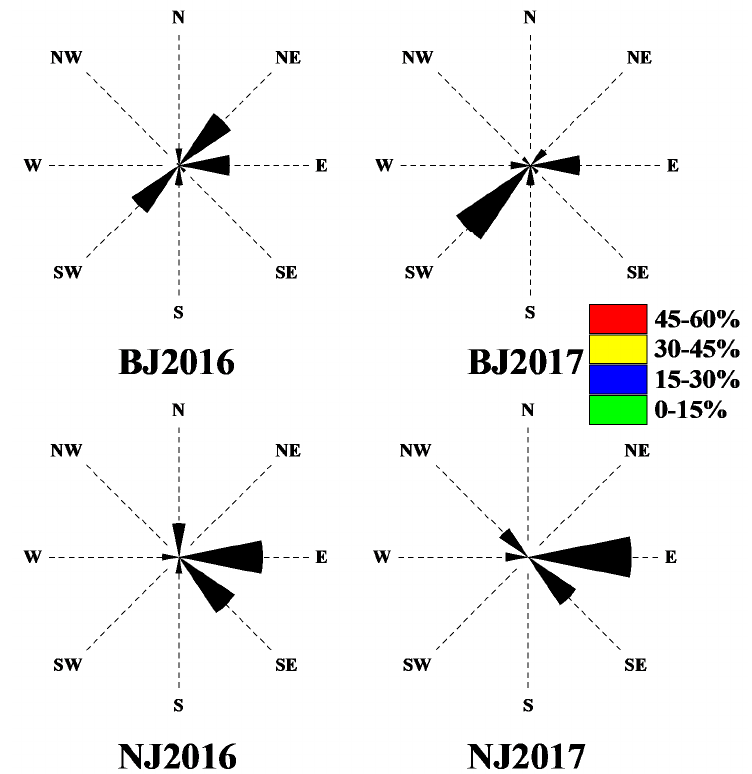
Figure 10. Distributions of heavily polluted days (when the ambient air quality index was more than 150) according to their respective wind 150) according to their respective wind directions.